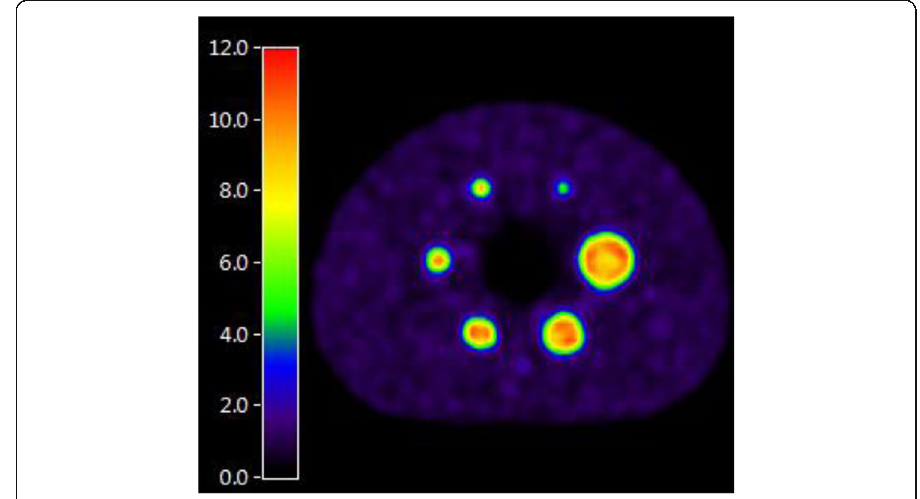
Fig. 1 Transversal slice of 89 Zr-filled NEMA NU2-2007 body